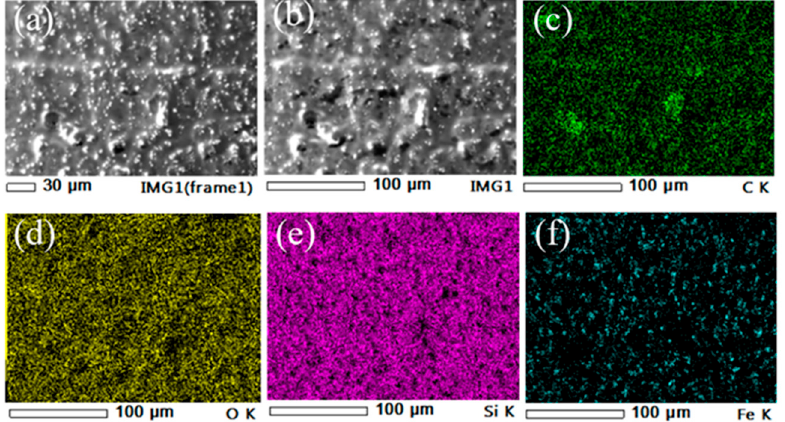
Figure 8. EDX mapping analysis of MRE sample consisting of ( a , b ) EDX region, ( c ) Carbon, green (C), ( d ) Oxygen, yellow (O), ( e ) Silicone, purple (Si) and ( f ) Iron, blue (Fe) elements.